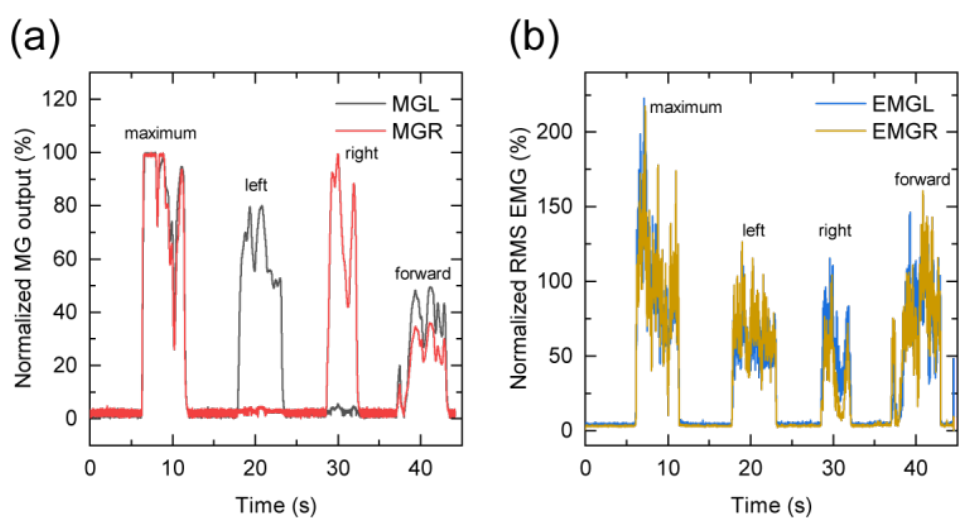
Figure 5. ( a ) MG sensor output and ( b ) EMG during the jaw movement task. These four peaks indicate the maximum teeth voluntary clenching and the left lateral, right lateral, and forward movements of the mandible, respectively.